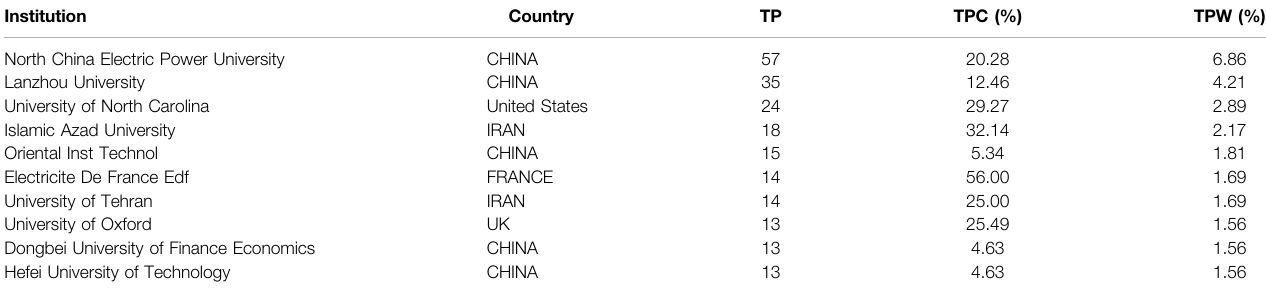
TABLE 2 | High-yield institutions in electricity demand